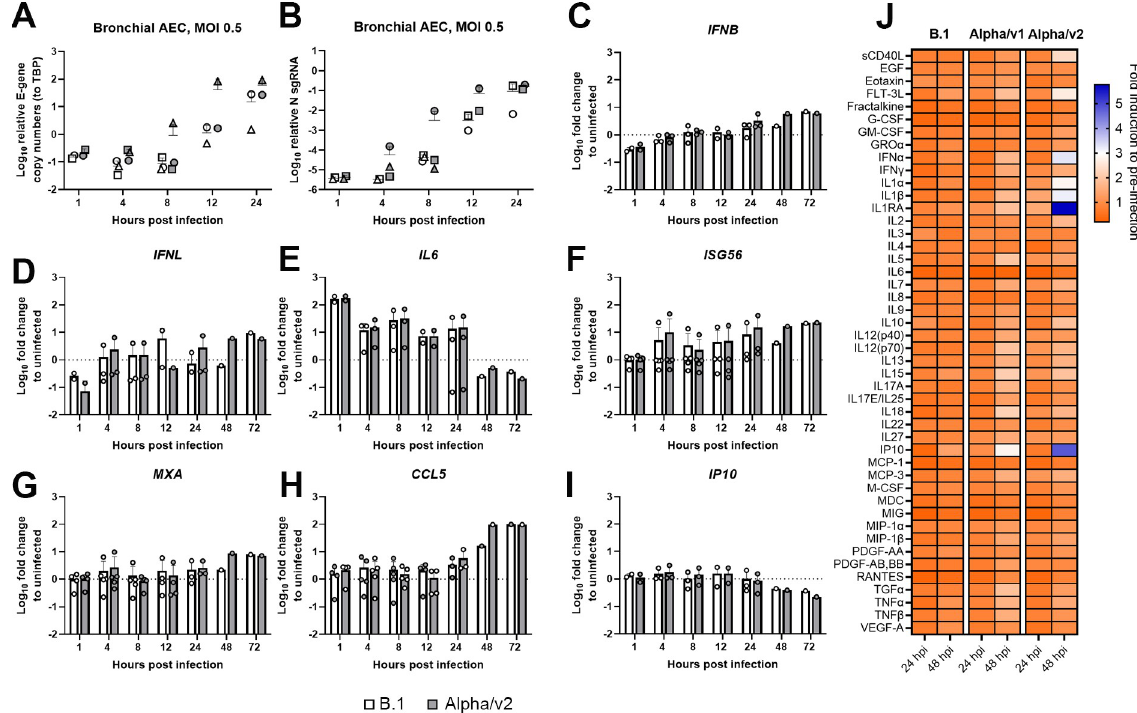
Fig 4. VOC Alpha and B.1 efficiently dampen induction of innate immunity in hBAECs. hBAECs were infected with B.1 or VOC Alpha (MOI of 0.5) and cell lysates were generated at the indicated time points followed by total RNA extraction. The experiment was performed with cells derived from 1–5 adult donors that were infected in duplicates. ( A ) Cell-associated expression of envelope in hBAECs during the early phase of infection determined by Q-RT-PCR. TBP was used for normalization. ( B ) Cell-associated expression of sgN in hBAECs during an early phase of infection determined by Q-RT-PCR. ( C – I ) Expression of the indicated genes was determined by Q-RT-PCR. Shown is the mean fold change +/ − SD. ( J ) Relative change (to pre-infection) of cytokines and chemokines concentration in the basal medium of infected hBAECs (MOI 0.5). Concentration of cytokines and chemokines was determined by MagPix Luminex technology. Paired t tests were conducted between B.1 and VOC Alpha-infected groups and scored negative. AEC, airway epithelial cells; hBAEC, human bronchial airway epithelial cell; MOI, multiplicity of infection; Q-RT-PCR, quantitative real-time PCR; sgN, subgenomic nucleocapsid; TBP, TATA-binding protein; VOC, variant of concern. See S1 Data.